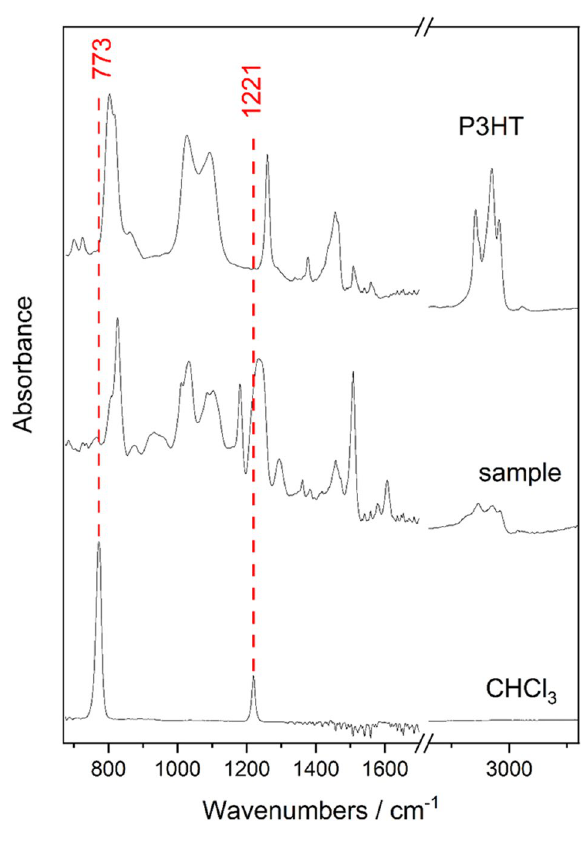
Figure 10. FTIR measurement.